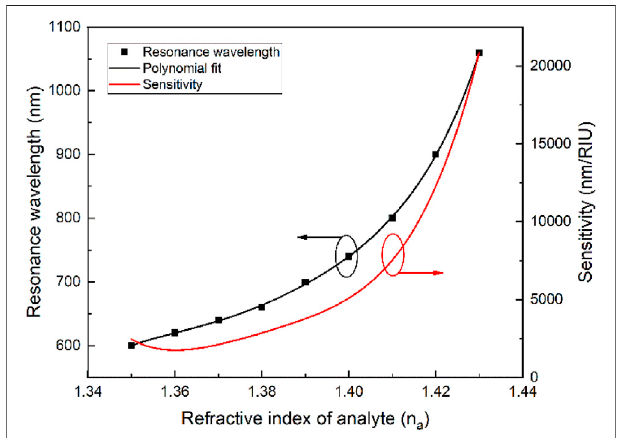
FIGURE 6 | Variation of the resonance wavelength and sensitivity with the RI of the analyte (n a ) for d (cid:2) 5 nm with t g (cid:2) 40 nm and 5% GeO 2 doped silica core. The lines represent a polynomial fi t made to the simulated values.